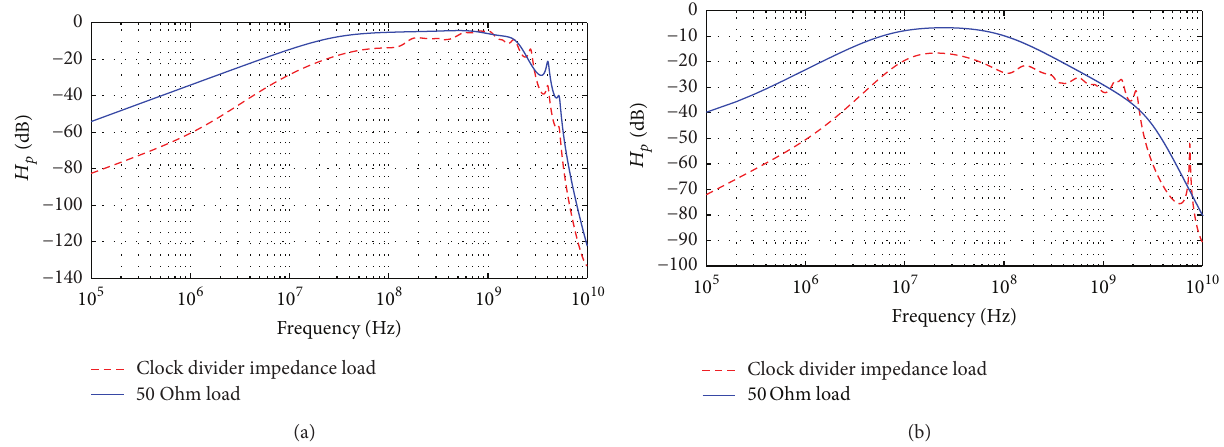
Figure 17: Comparison of power transfer efficiency under different load conditions. (a) DPI method. (b) BCI method.